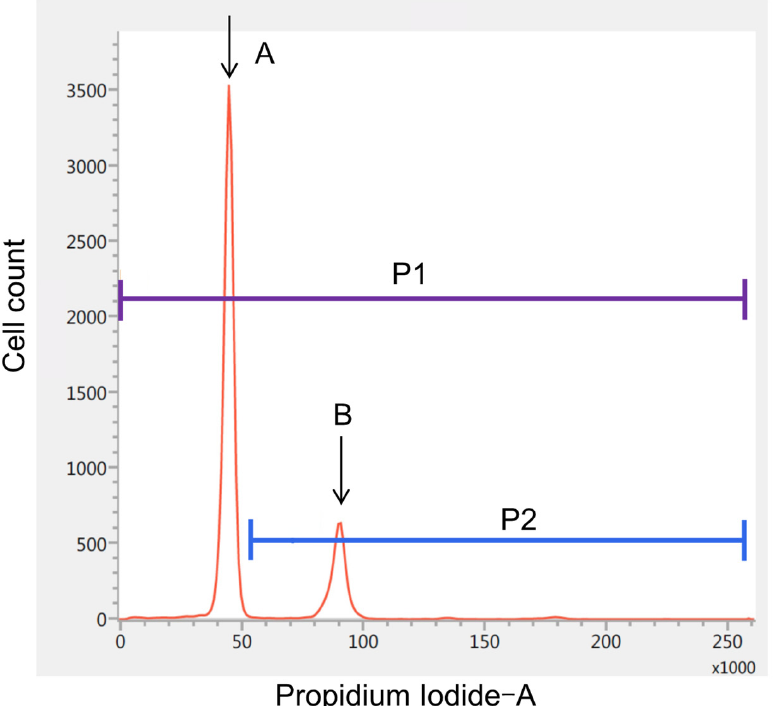
Figure 1. DNA ploidy analysis using intraoperative flow cytometry. The horizontal axis represents the intensity of propidium iodide fluorescence. Peak A indicates the cluster of G 0 G 1 -phase (diploid) cells, whereas Peak B represents that of tetraploid G 2 /M-phase cells. The proliferation index was defined as the ratio of the number of cells with greater-than-normal DNA content (P2) to the total number of cells (P1).